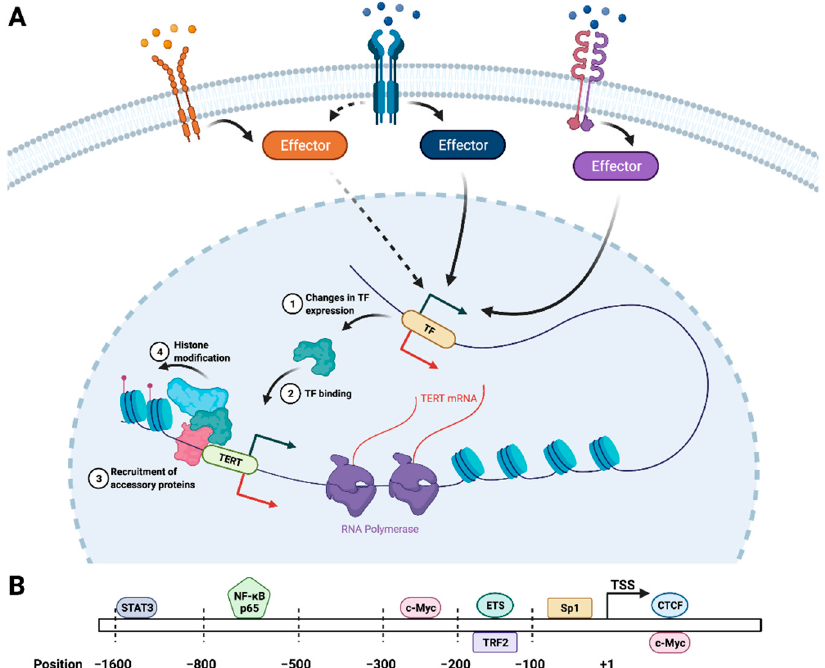
Figure 1. Transcriptional regulation of TERT. ( A ) TERT transcription is mediated by the coordinated actions of myriad intracellular signaling pathways that are initiated by specific ligands (e.g., growth factors, cytokines). The downstream effectors of these receptor-ligand interactions activate (green arrow) or repress (red arrow) the expression of TERT as well as TFs that regulate TERT expression ( 1 ). As a consequence of transcriptional up- or downregulation, these TFs (represented by the green protein) are more or less able to engage the TERT promoter, both on their own ( 2 ) and in conjunction with accessory transcriptional regulators (represented by the pink and blue proteins) ( 3 ). These accessory factors include histone-modifying enzymes, which alter the chromatin landscape at the TERT promoter to facilitate or inhibit transcription ( 4 ). The diversity of signaling inputs and TFs that oversee TERT transcription enable combinatorial control of telomerase function in response to intracellular and extracellular conditions. ( B ) The human TERT promoter harbors binding sites for the major transcriptional regulators of TERT expression [shown as approximate nucleotide position relative to the transcription start site (TSS)] [64–68] . TFs shown above and below the chromosome (rectangle) have binding motifs located on overlapping segment of the TERT promoter, rather than binding in opposing orientations.